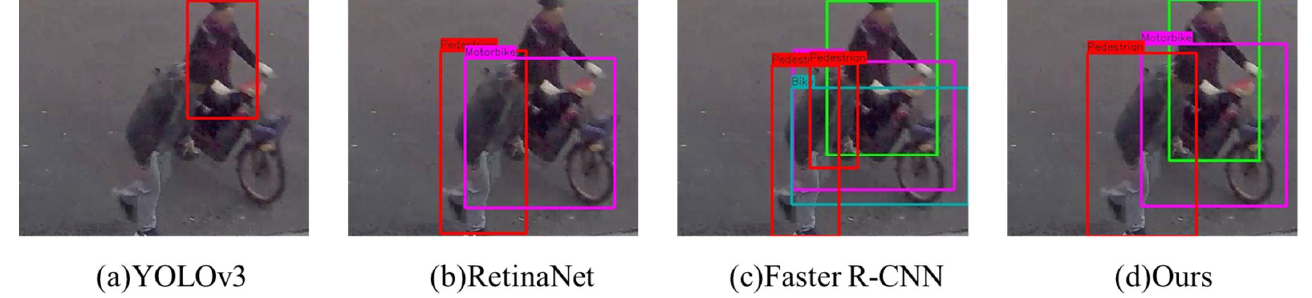
Figure 5. The detection results of the position of Pedestrian , Rider , and Motorbike .